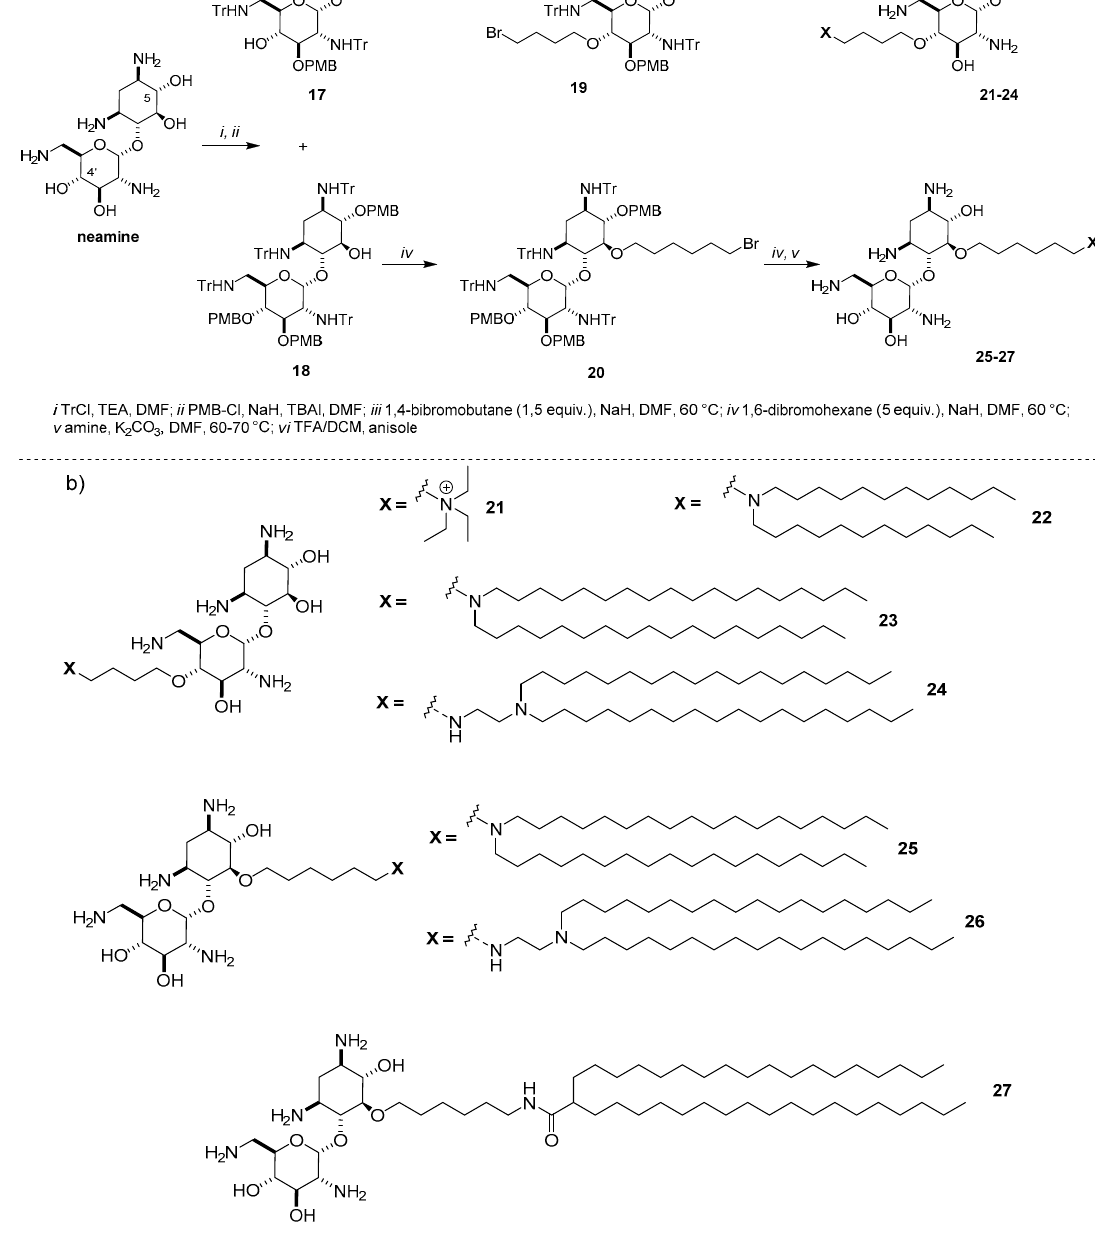
Figure 8. ( a ) Synthesis and ( b ) structures of lipids 21 – 27 bearing one neamine unit.